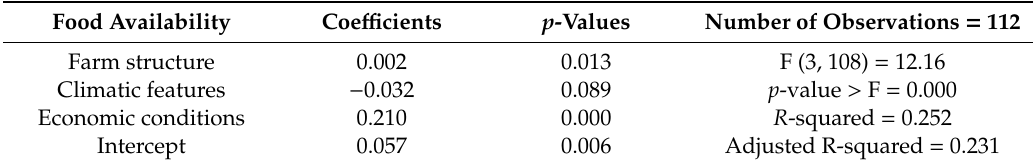
Table 5. The estimated results of Pooled-OLS regression; Source: own calculations. Food